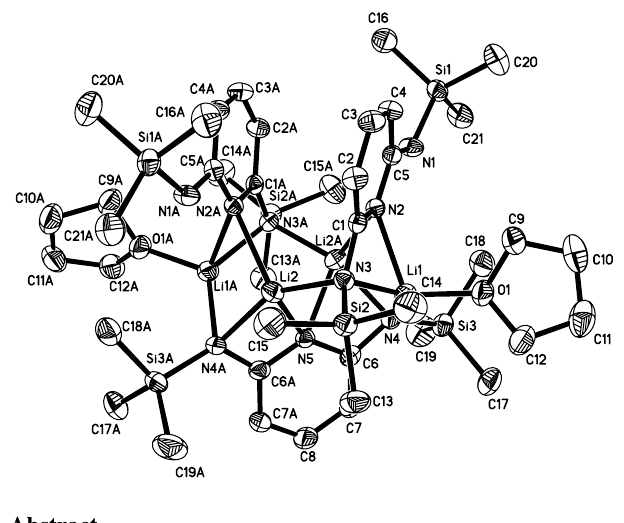
Table 2. Atomic coordinates and displacement parameters (in Å 2 )